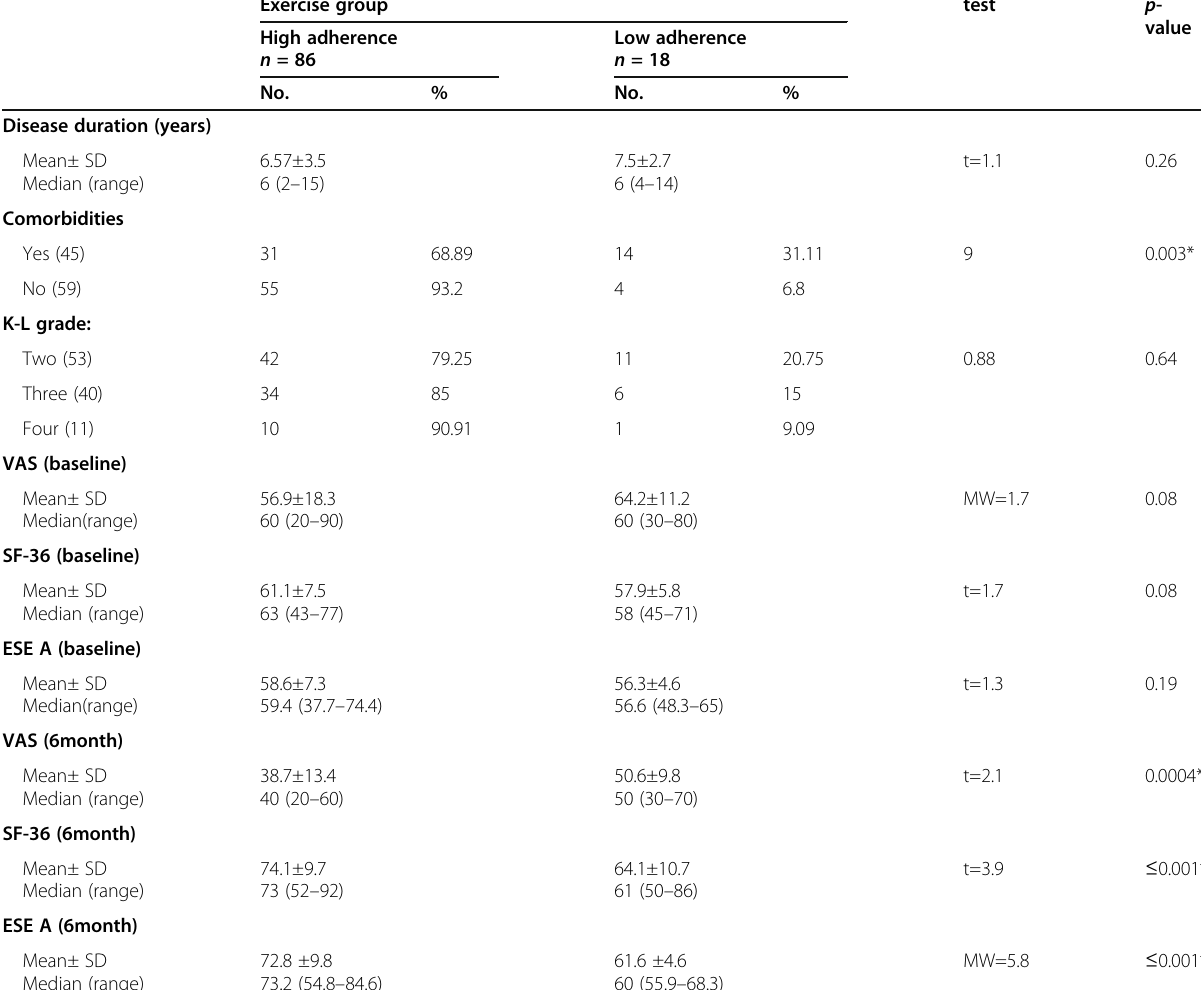
Table 4 Relation of adherence level to HEP among exercise group with regard to clinical characteristics and outcome measures Exercise group test p -